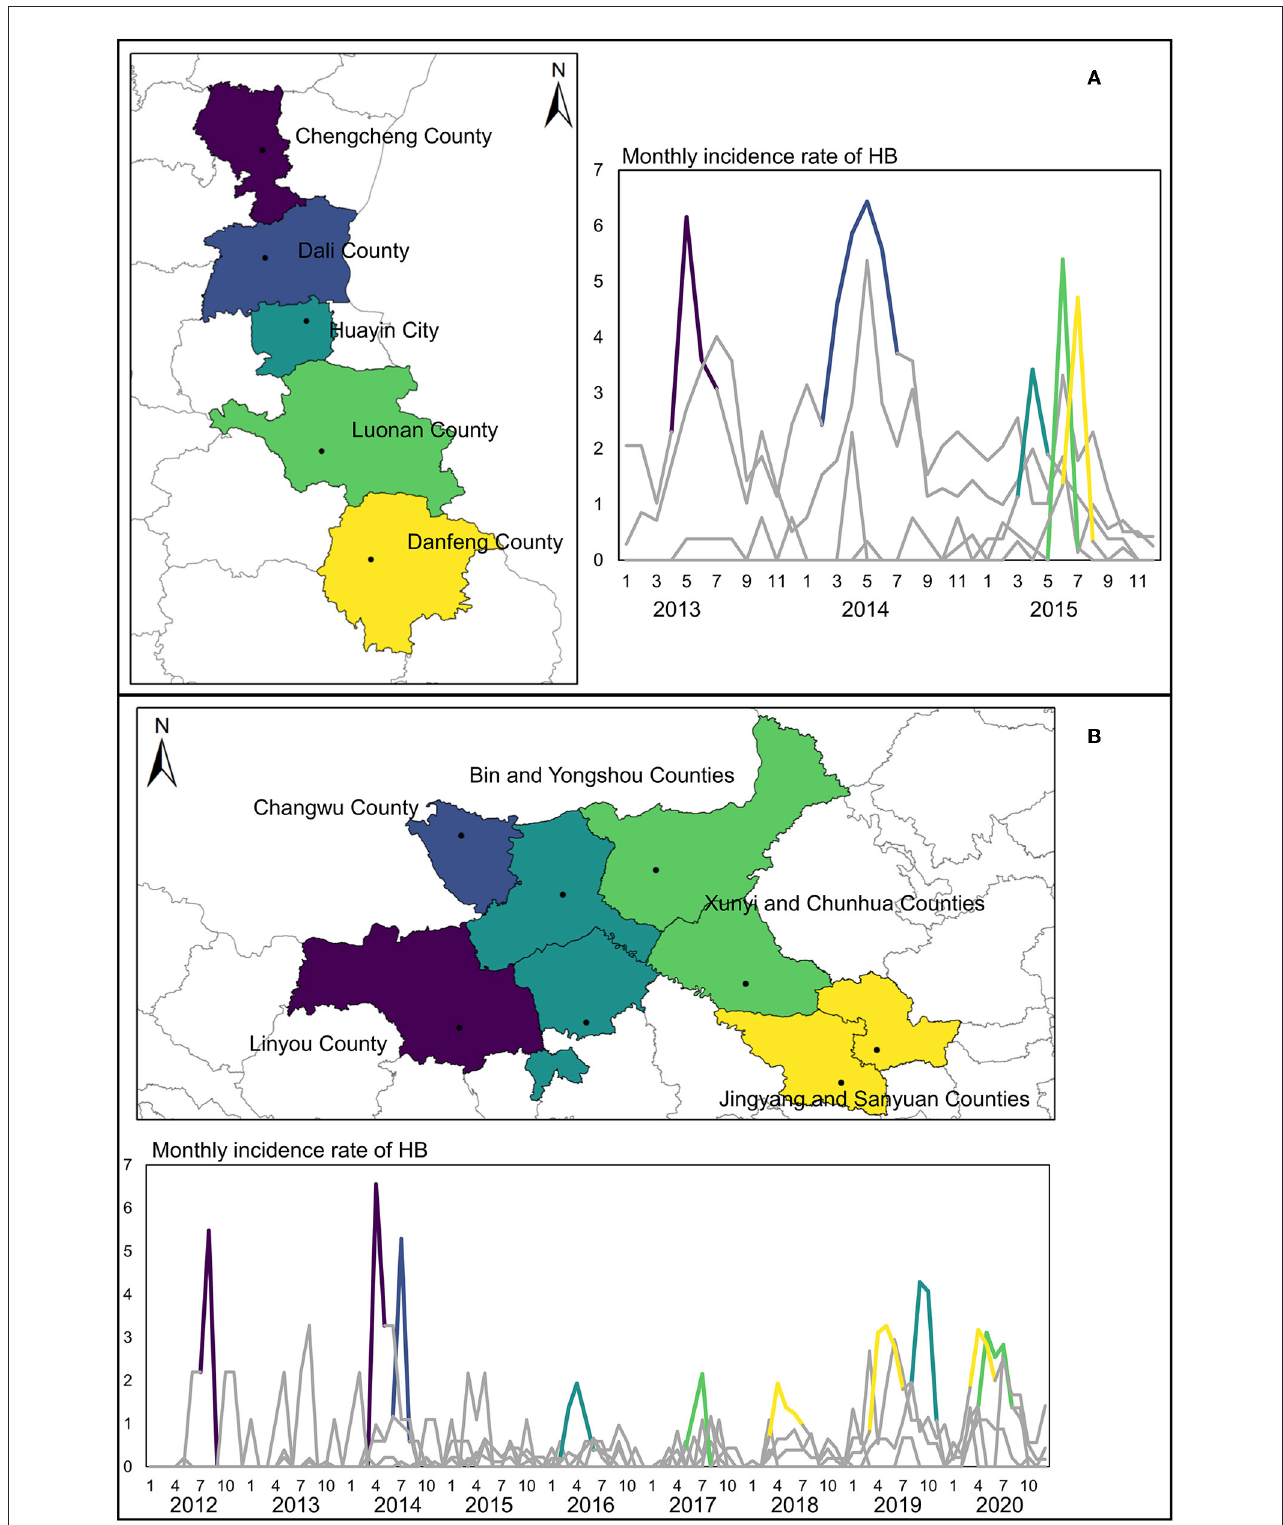
FIGURE5 Monthly time series of HB cases and peak periods in two key regions. (A) Peaks of the time series of HB cases in the Weinan-Shangluo region. (B) Peaks of the time series of HB cases in the left region of the Guanzhong Plain.